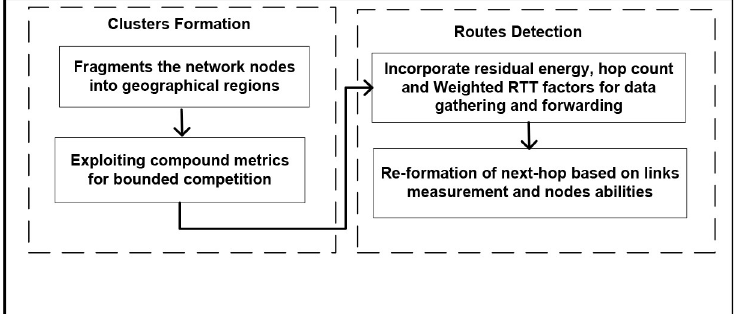
Fig 1. Design of RCER